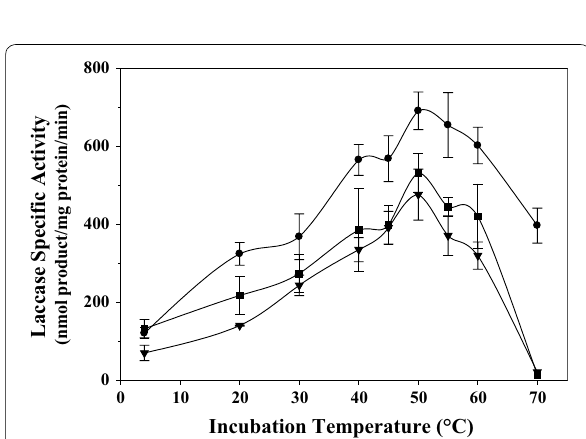
Fig. 3 Thermostability profile of the lyophilized laccase activity, after 2 h of incubation at different temperatures, assayed with syringaldazine as substrate. The reaction mixture contains the enzymatic preparations including the control being the lyophilized enzyme without additive (black circle) with 2.5% (w/v) mannitol (black down‑pointing triangle) and 2.5% (w/v) dextran 15 to 25 kDa (black square) as